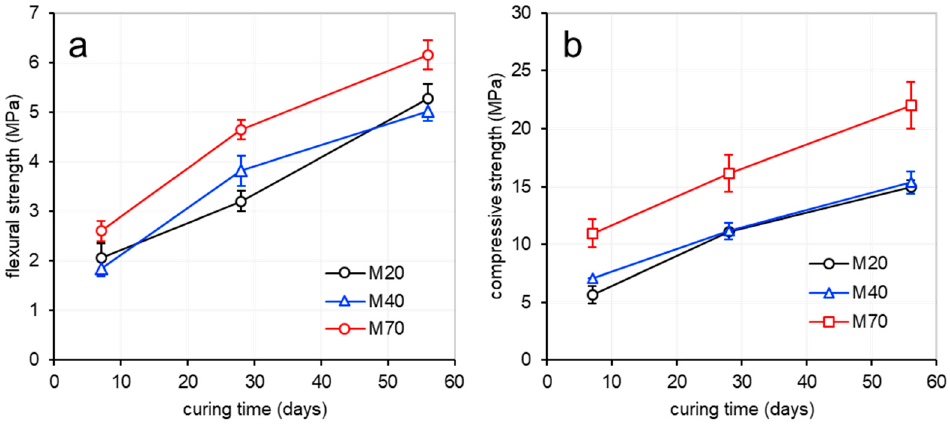
Figure 3. Mechanical properties of activated mortars. ( a ) Flexural strength, and ( b ) compressive strength.